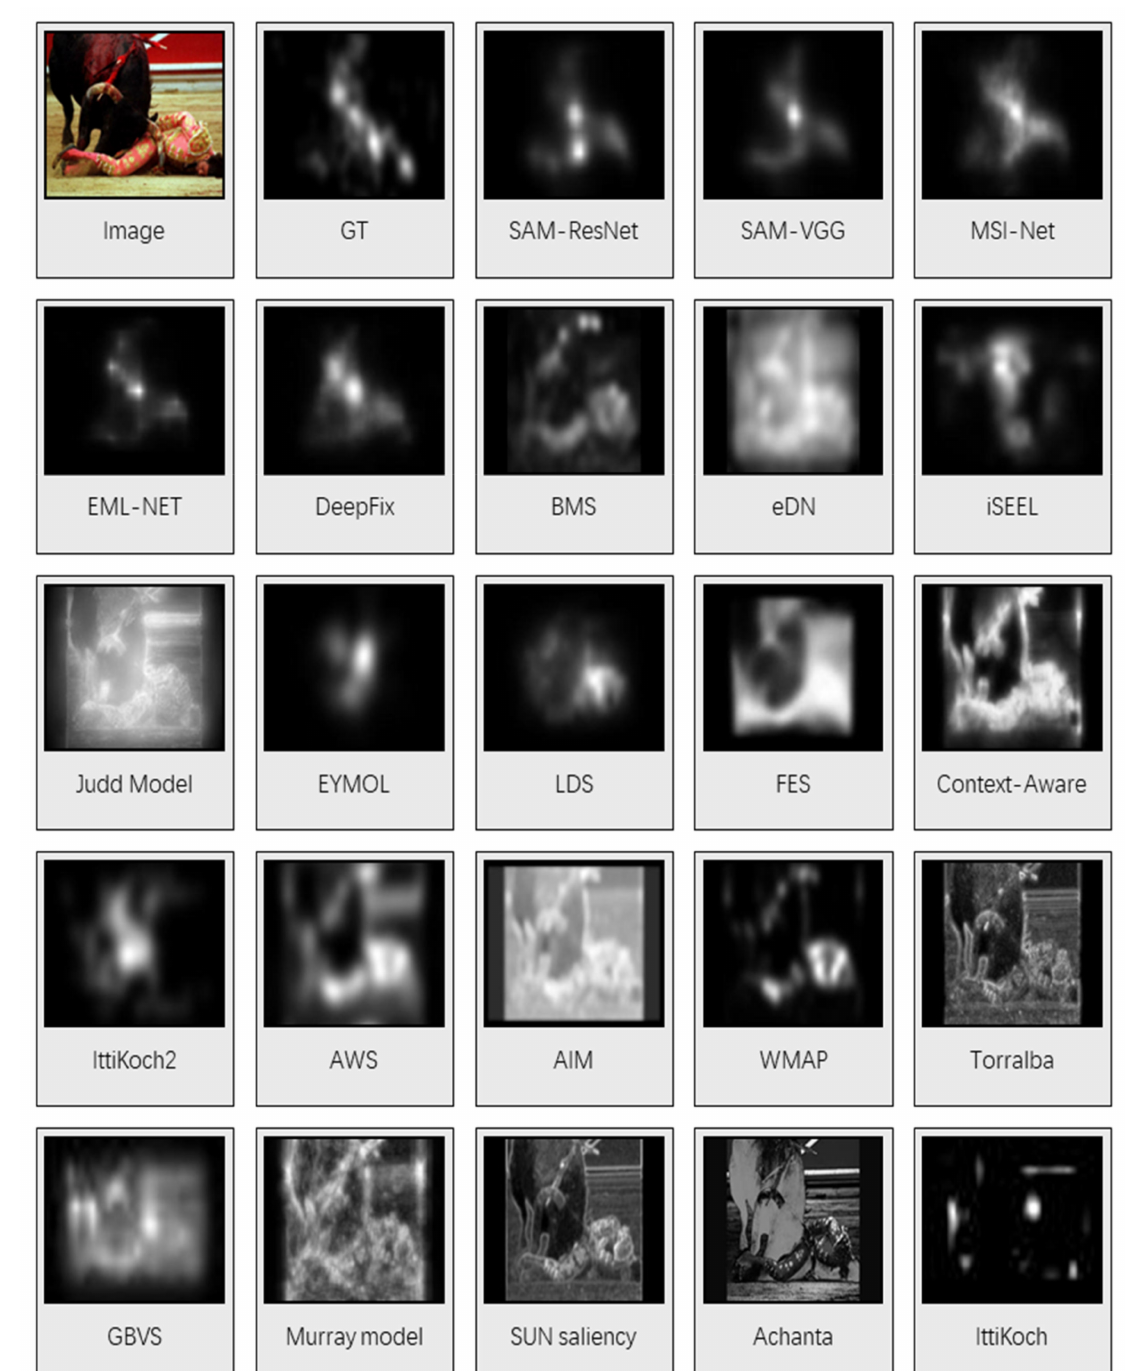
Figure 4. Saliency maps over the CAT2000